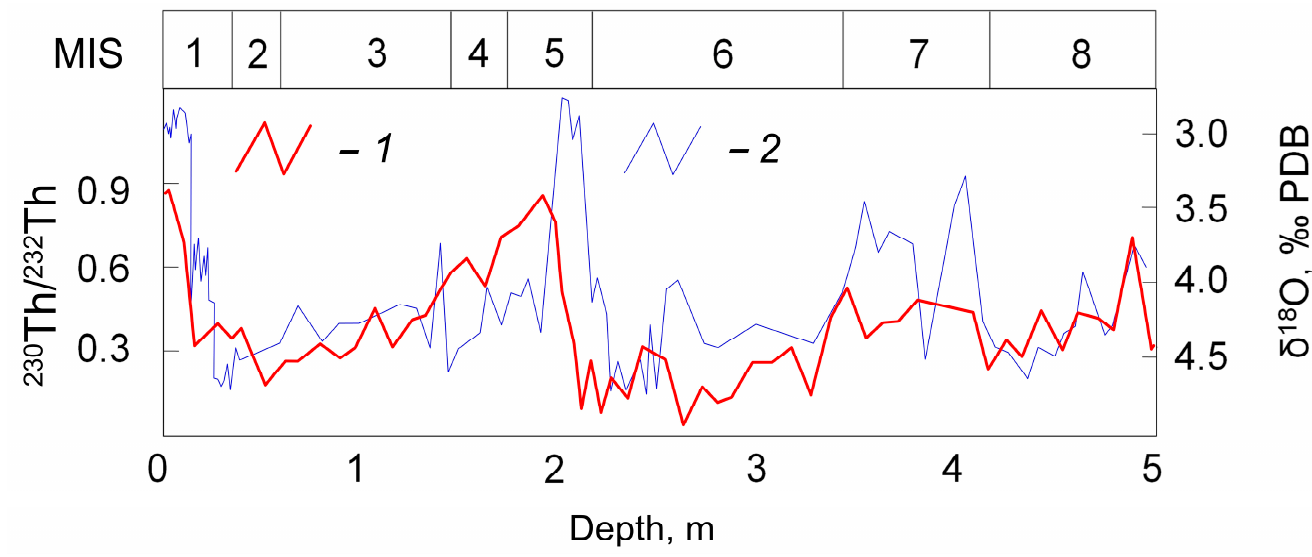
Figure 2. Initial 230 Th/ 232 Th ratio and oxygen isotopic composition of carbonates for core 23059 from the Norwegian Sea for the period MIS 1–8 (adapted from [77] with changes): 1—isotopic composition of thorium; 2—isotopic composition of oxygen.